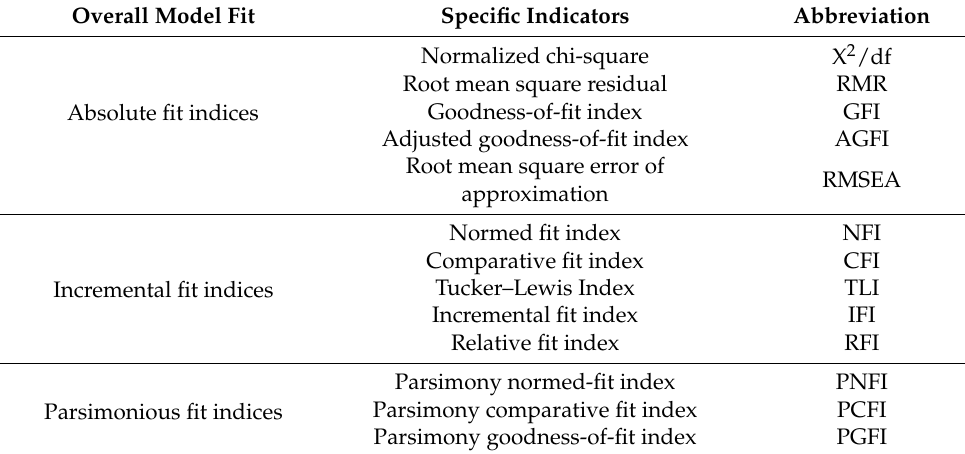
Table 2. Indicators to verify the effectiveness of the model.